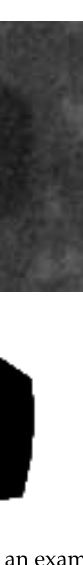
Fig. 12: Image segmentation for diamonds: (a) an original CT image;